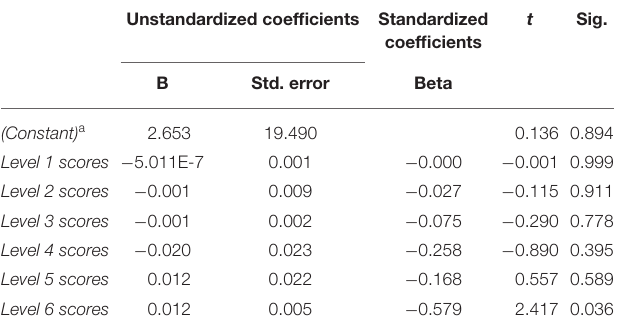
TABLE 7 | Regression analysis for predictive